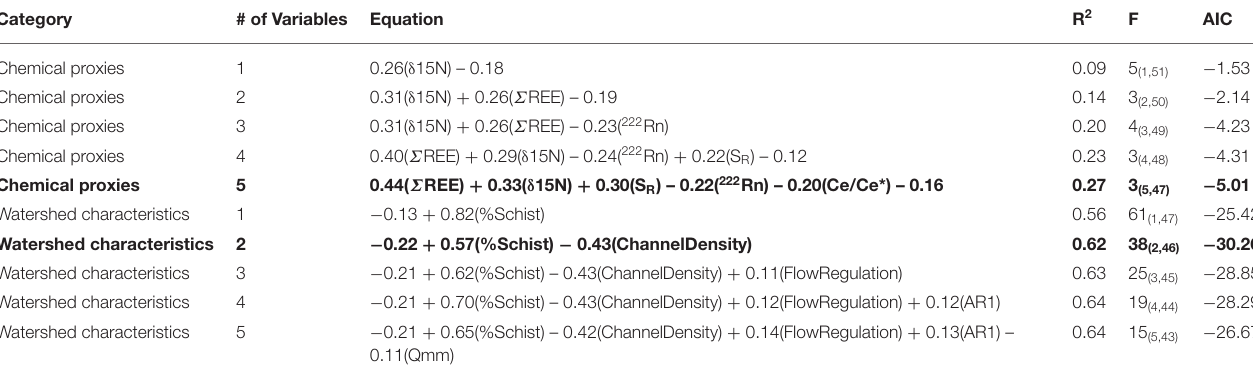
TABLE 3 | Multiple linear regression models for P attenuation using chemical proxies and watershed characteristics. Category